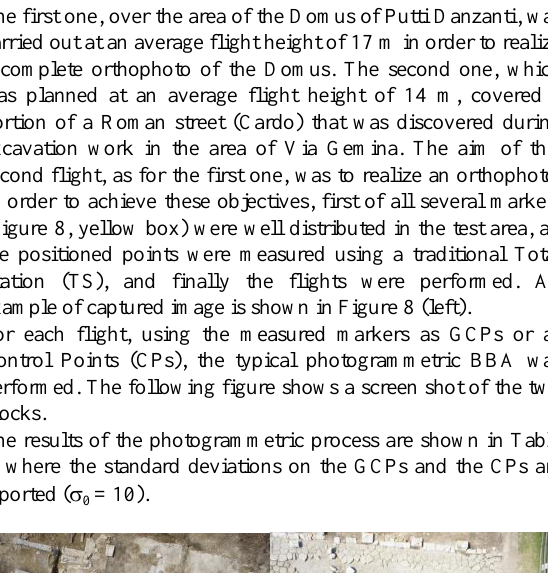
Table 3 Standard deviations on the GCPs and the CPs in the analysed